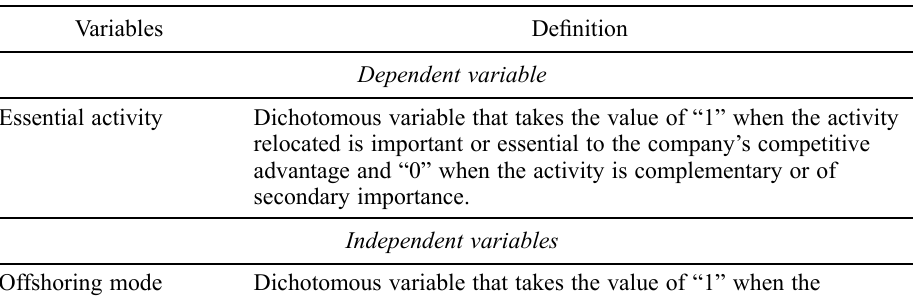
Table 5. Exact operationalization of the included